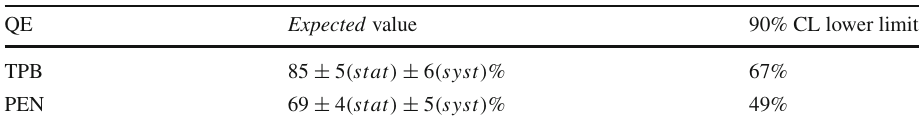
Table 5 QE of TPB and PEN using the expected values of the optical parameters and 90% CL lower limit on the QE of